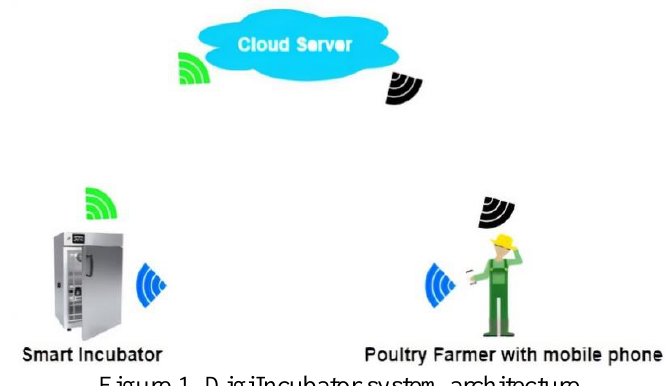
Figure 1. DigiIncubator system architecture